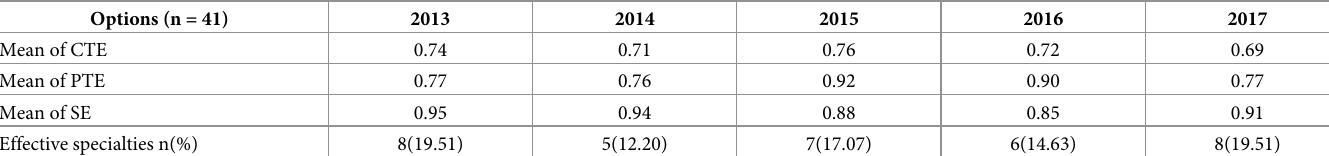
Table 1. Descriptive statistics of the specialties’ annual efficiency in 2013–2017.